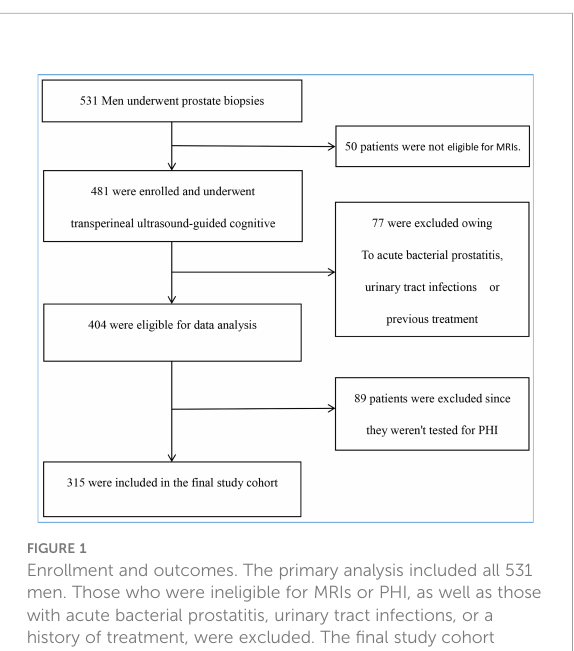
FIGURE 1 Enrollment and outcomes. The primary analysis included all 531 men. Those who were ineligible for MRIs or PHI, as well as those with acute bacterial prostatitis, urinary tract infections, or a history of treatment, were excluded. The fi nal study cohort consisted of 315